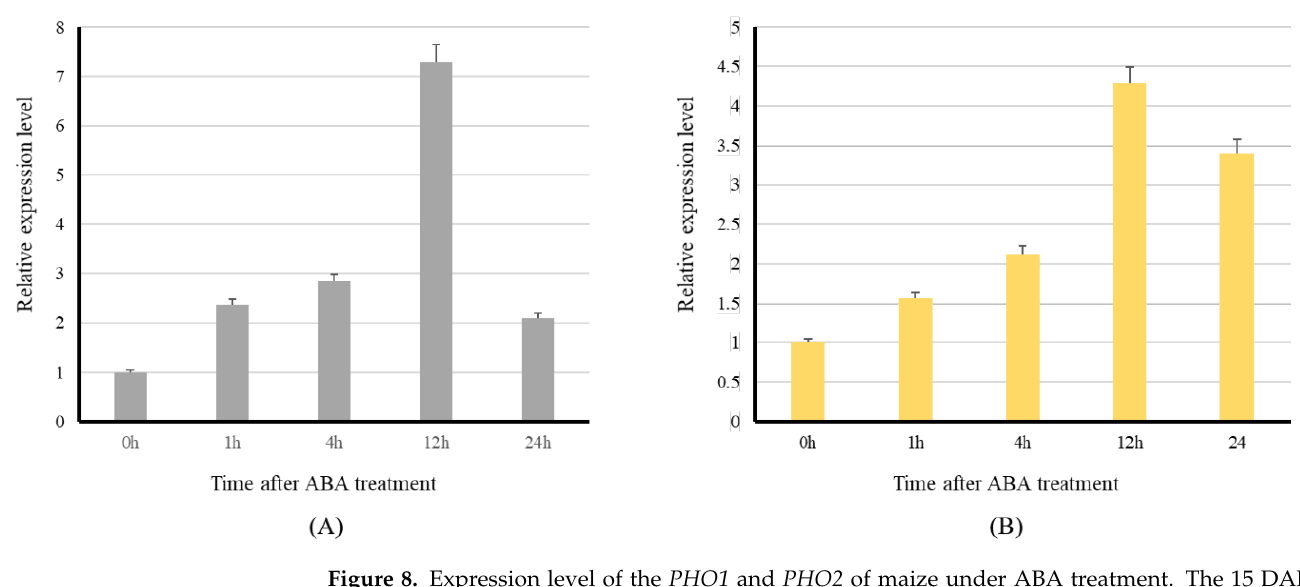
Figure 8. Expression level of the PHO1 and PHO2 of maize under ABA treatment. The 15 DAP middle seed of corn cob was used to treat with ABA in MS medium. Furthermore, 0 h indicates no ABA treatment and is used as a control. ( A ) Effect on PHO1 transcripts expression. ( B ) Effect on PHO2 transcripts